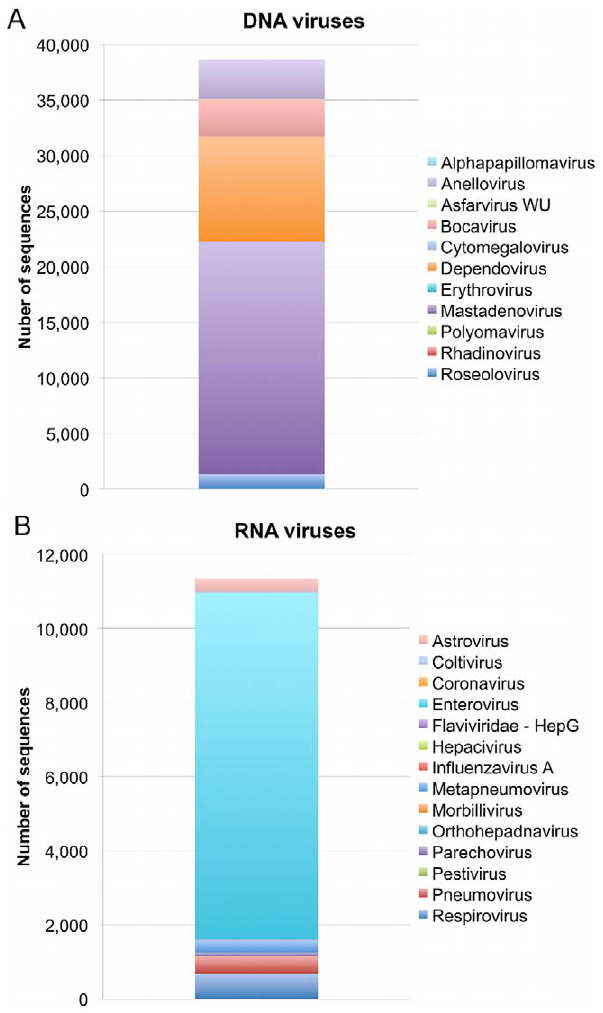
Figure 2. Sequence analysis identifies a variety of viruses in samples from febrile and afebrile children. Analysis of 176 plasma and NP samples on the Illumina GAIIX and HiSeq 2000 platforms identified approximately 50,000 sequences with similarity to 25 known (A) DNA and (B) RNA virus genera.